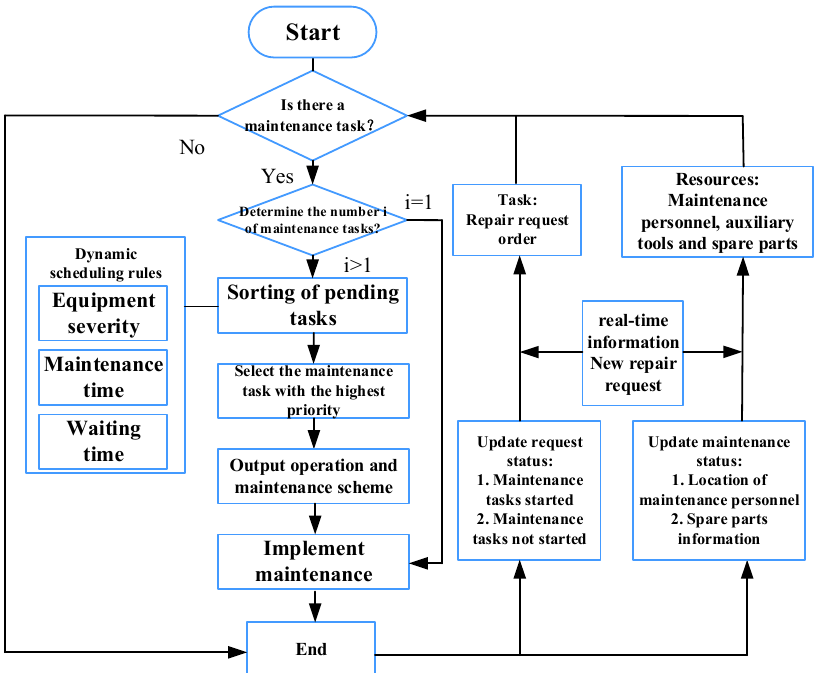
Figure 3. Dynamic scheduling model of harvester maintenance tasks.